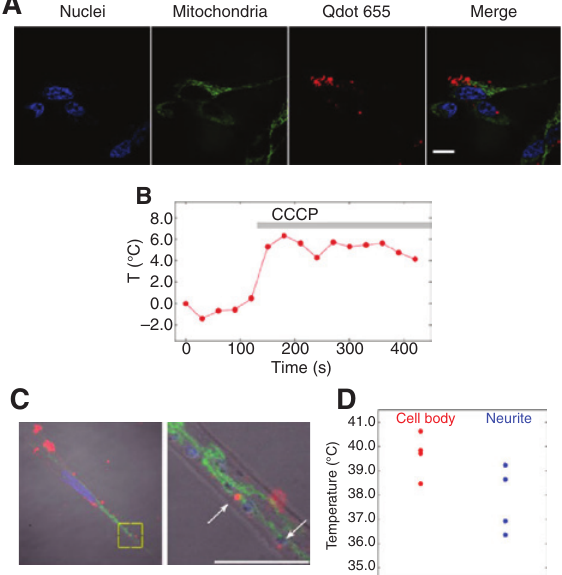
Figure 18: Intracellular thermometry of living cells using Qdot 655 nanocrystals. (A) Confocal fluorescence images of living SH-SY5Y cells labeling nuclei with Hoechst 33342 (blue) and mitochondria with Mito-Tracker Green FM (green) and incorporating quantum dots (red, λ and their merged image. Scar bar = 20 μ m. (B) Change in the tem- perature near a single Qdot 655 nanocrystal using chemical stimuli with 10 μ m CCCP. (C) The merged images of Hoechst 33342 (blue), Mito-Tracker Green FM (green), Qdot 655 nanocrystals (red) and DIC in a neuronal cell. The right image is the enlarged image of the yellow square in the left image. Arrows point to the quantum dots. Scar bar = 10 μ m. (D) Temperature difference between the cell body (red) and the neurite (blue) in neuronal cells. The mean difference was 1.6 ° C (p-value = 0.062). Reproduced from Tanimoto et al. (2016).